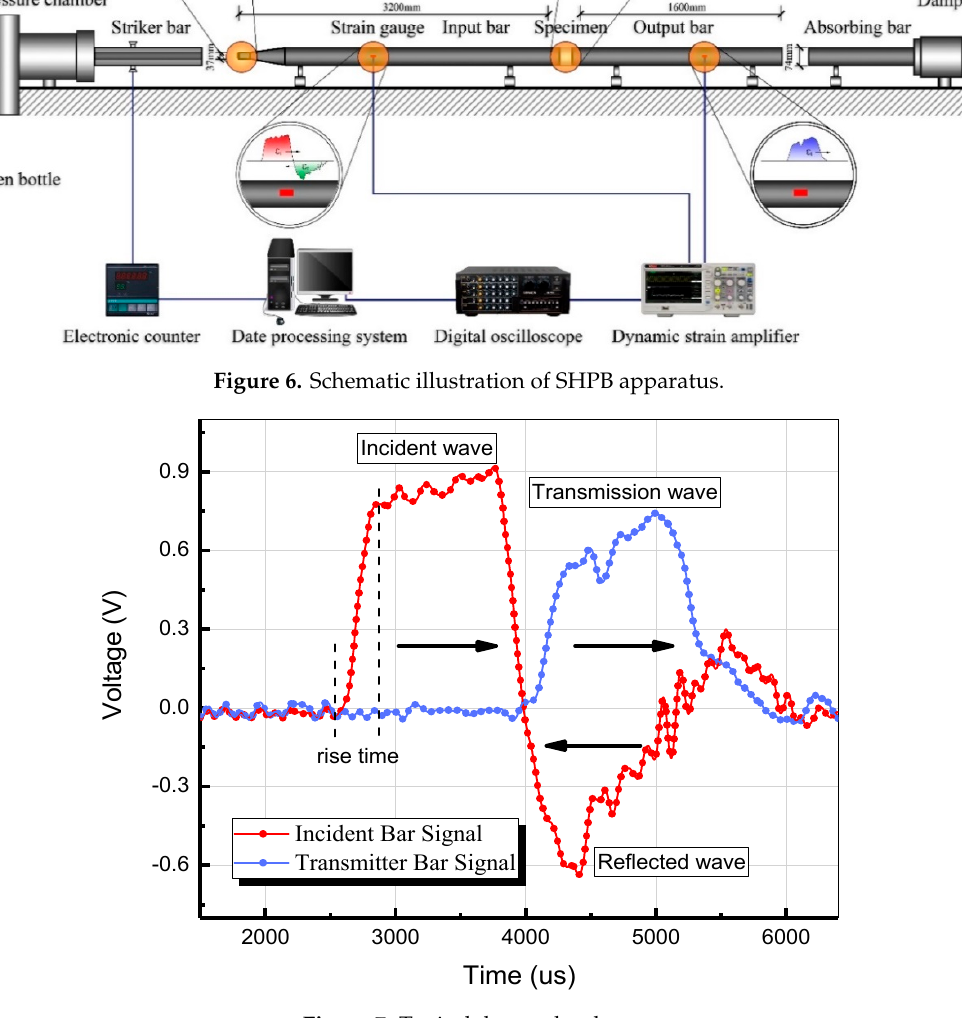
Figure 7. Typical detected pulses.